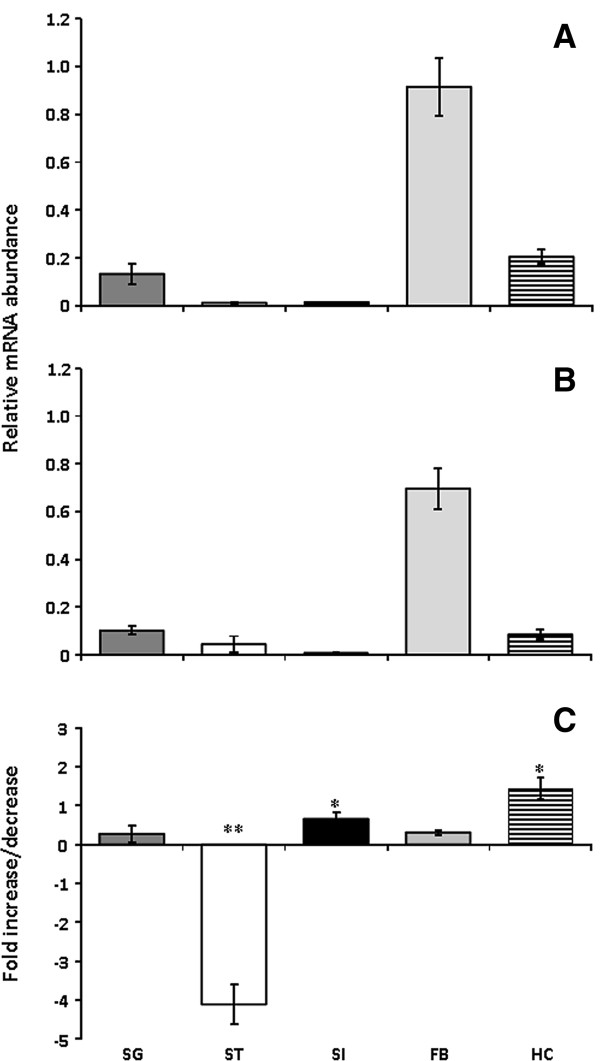
Relative transcript abundance of PMSRP1 encoding mRNA in different tissues of fifth-instar nymphs after 25 cycles in relation to ß-actin, A- Seven days after a blood meal containing T. cruzi strain Dm28c (2 × 106 cells/ml), B- Seven days after a parasite-free blood meal (control), C- Fold increase (positive axis) and decrease (negative axis) transcript abundance of PMSRP1 in infected insects (A) compared with the uninfected control (B). Asterisks relates to significant differences (*P < 0.01, **P < 0.001) obtained after statistical analyses using one way ANOVA and Student’s t-test. SG – salivary glands, ST – stomach, SI– small intestine, FB – fat body, HC – hemocytes.